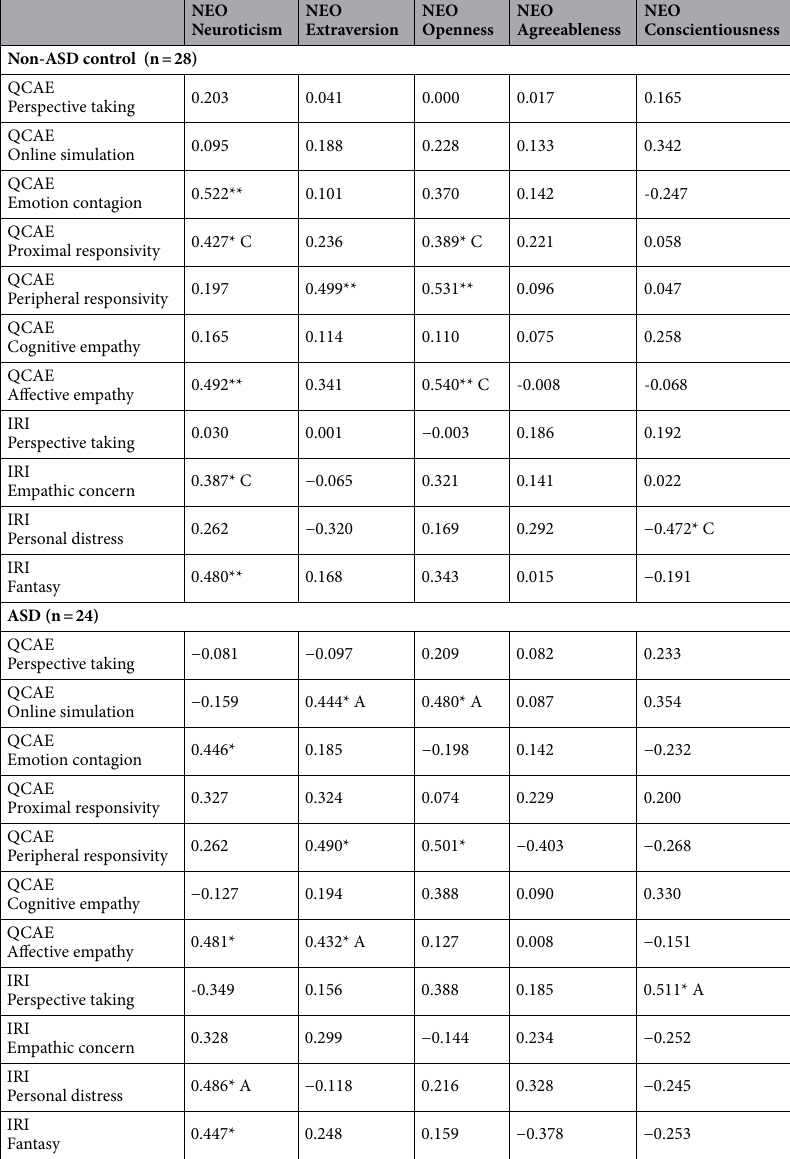
Table 6. Correlations between empathy and personality. Values are Pearson’s r correlations. IRI Interpersonal Reactivity Index, NEO NEO Personality Inventory-Revised, QCAE Questionnaire of Cognitive and Affective Empathy, C only within control subjects, A only within ASD patients. * p < 0.05,** p < 0.01, coefficient in each